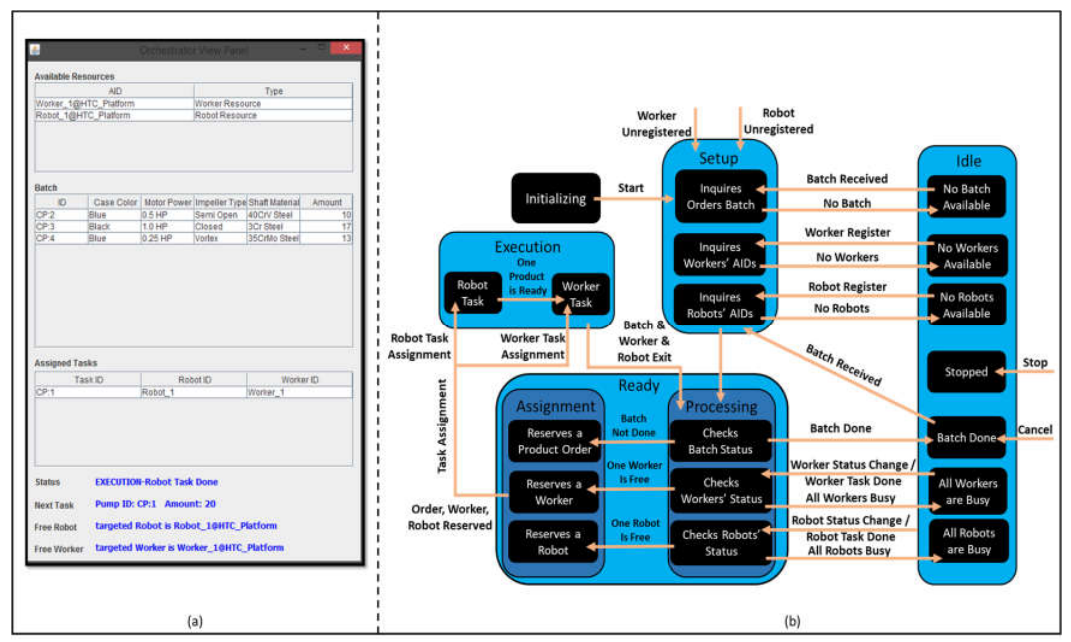
Figure 8. ( a ) SH (Supervisor Holon) User Interface; ( b ) SH State-Machine.